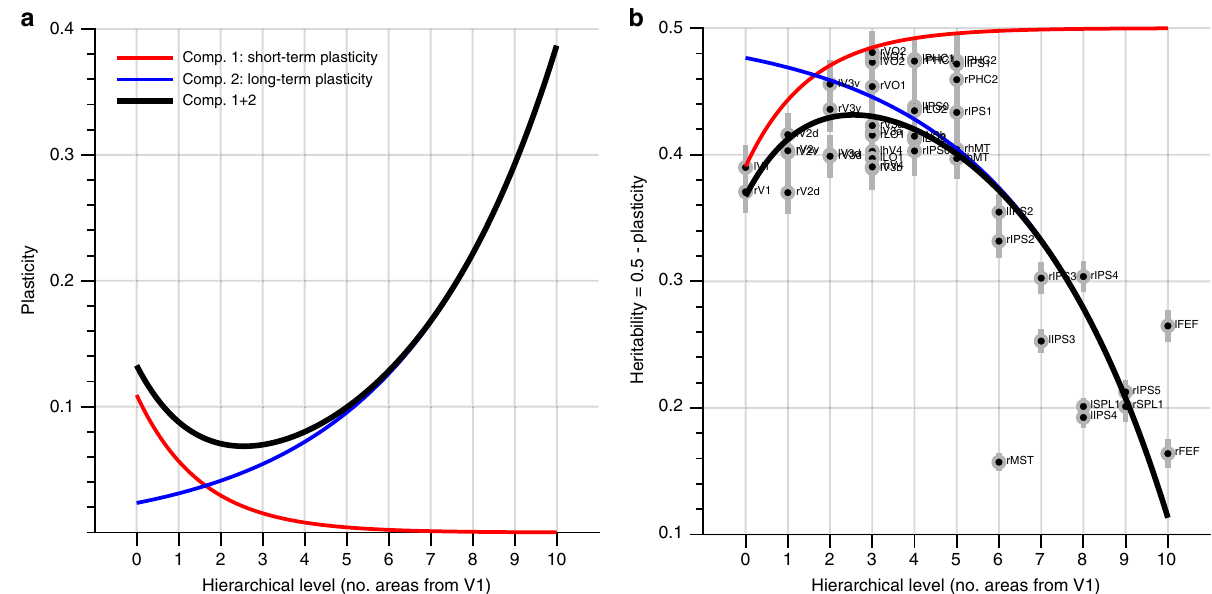
Fig. 2 Theoretical model of the relationship between heritability and hierarchical level. a The non-monotonic relationship between heritability and hierarchical level can be modeled as the complement of the sum of transient short-term plasticity and sustained long-term plasticity components. Under this model, short-term plasticity (red) is relatively weak and decreases exponentially from low to high levels of visual processing, whereas long-term plasticity (blue) increases exponentially to become relatively strong in high-level visual cortex. b Under the assumption that the average heritability estimates shown in Fig. 1b peak at 0.5 (due to e.g. measurement noise common to all hierarchical levels of processing), the complement of the sum of both components (black) predicts the observed heritability estimates very well ( R 2 = 0.73). Source data are provided as a Source Data fi